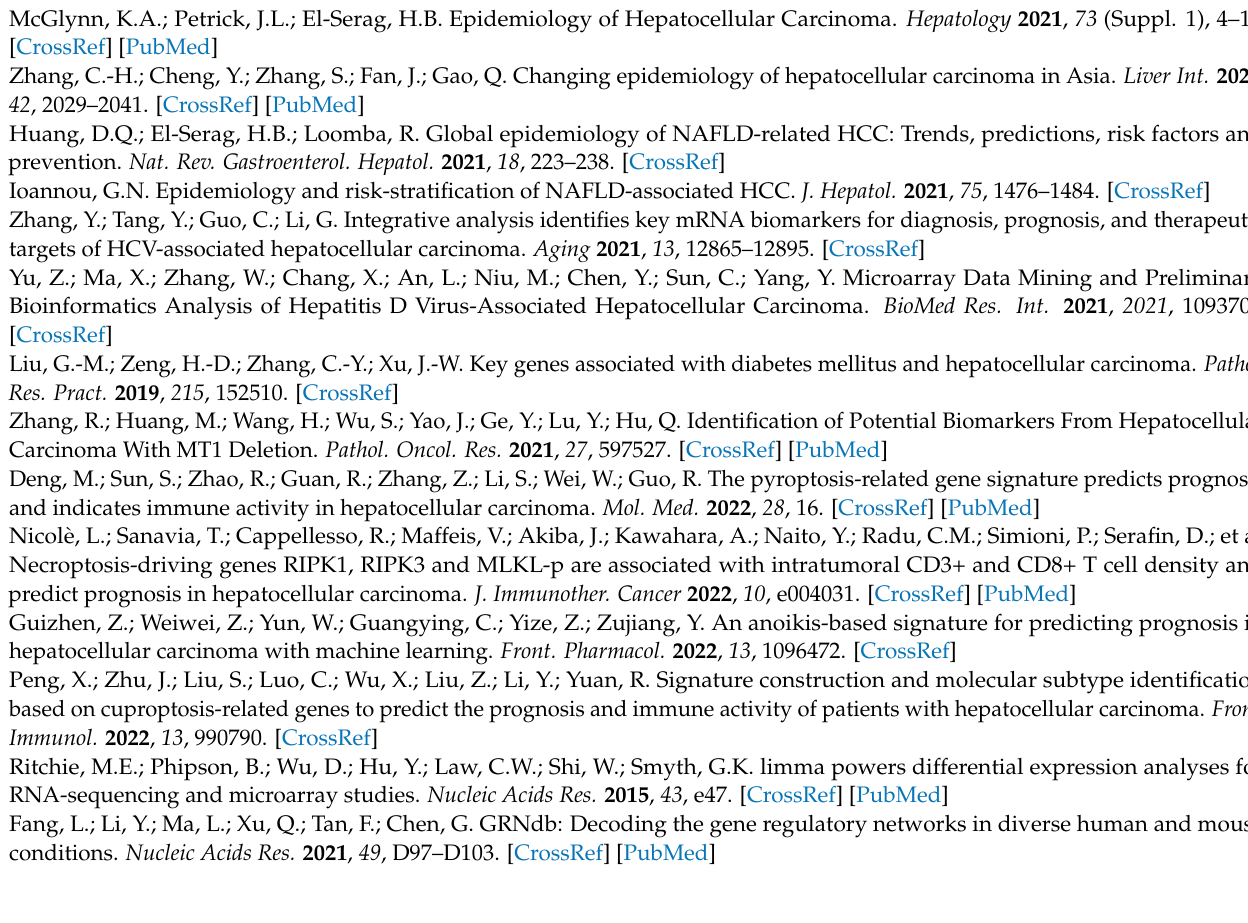
Table S4. Predictive lncRNAs from StarBase V2.0.; Table S5. The landscape of mutation in pan-cancer; Table S6. Drug sensitivity data in pan-cancer; Table S7. Immune infiltration analysis in pan-cancer; Table S8. Abbreviation